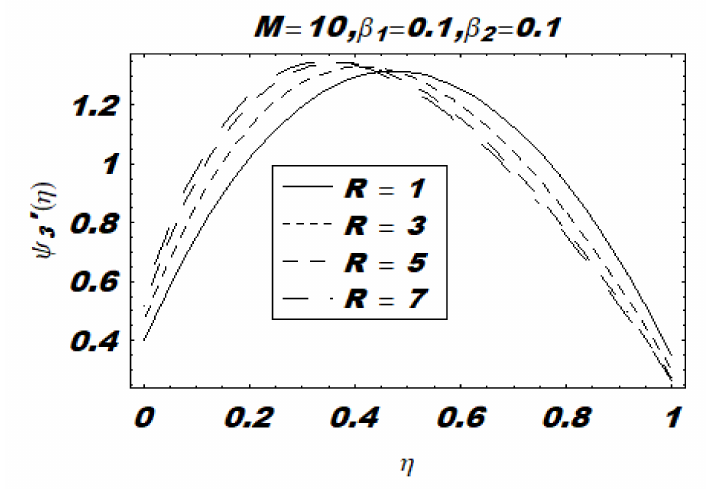
Figure 10. Similarity function ψ /